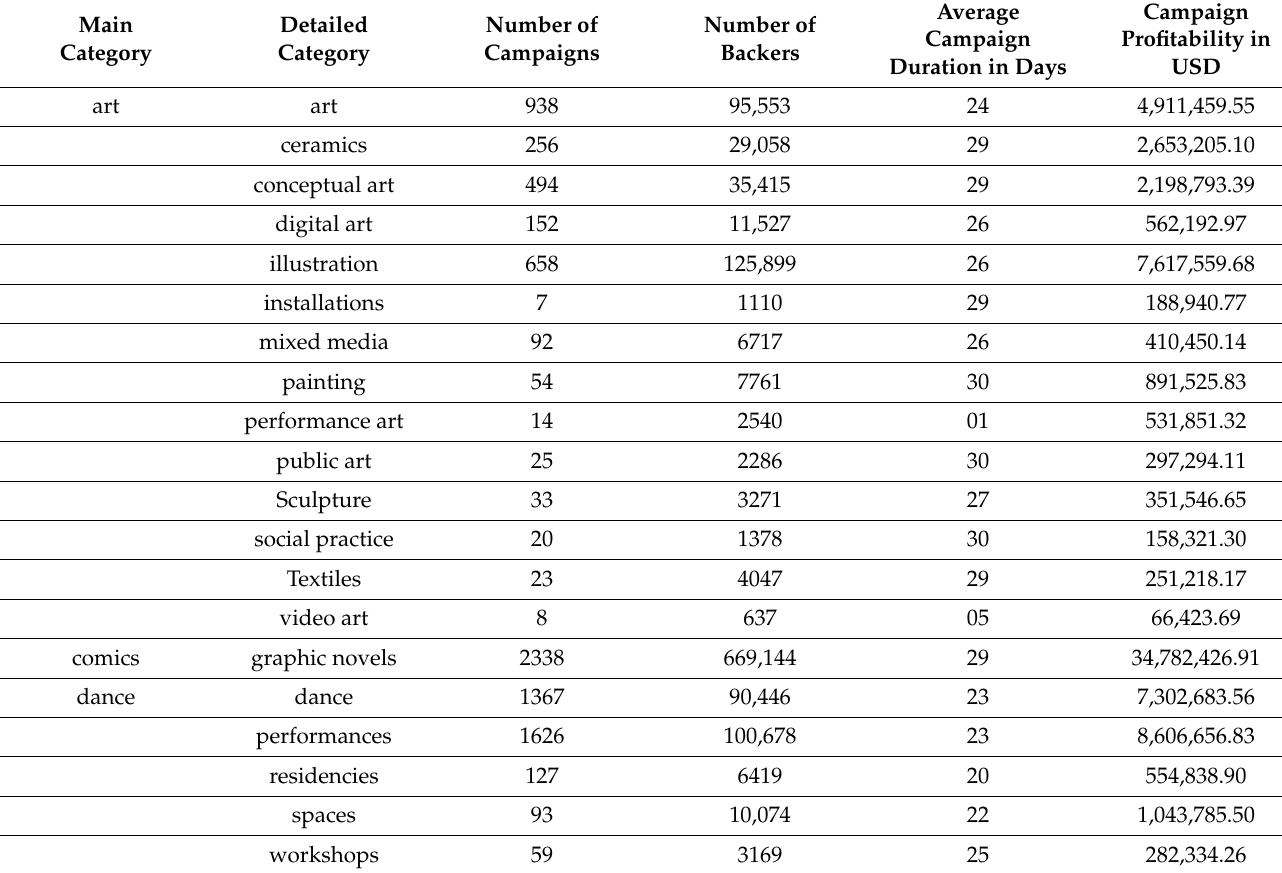
Table 3. Summary of general source